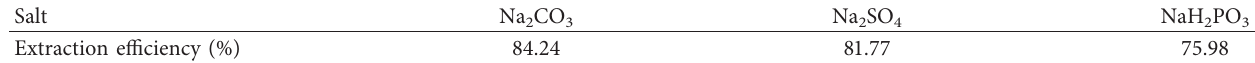
Figure 6: HPLC by UV detection of real samples: left, deionized water sample after ATPS extraction; right, deionized water sample added with 50mg/mL vitamin B 6 after ATPS extraction. Table 9: The date of extraction efficiency on salts.